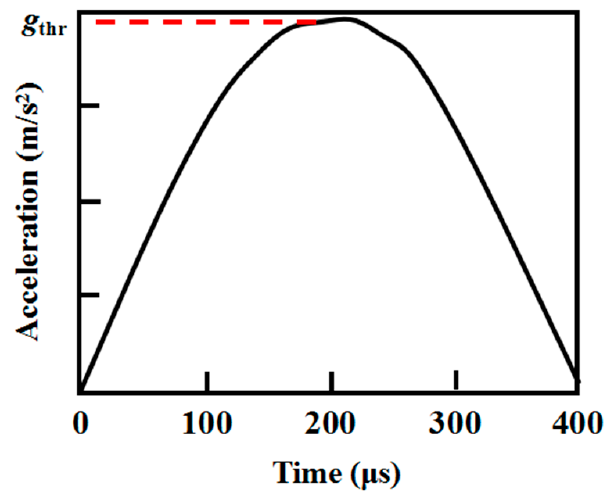
Figure 6. Half-sine acceleration curve. Figure 6. Half ‐ sine acceleration curve. Figure 6. Half ‐ sine acceleration curve.